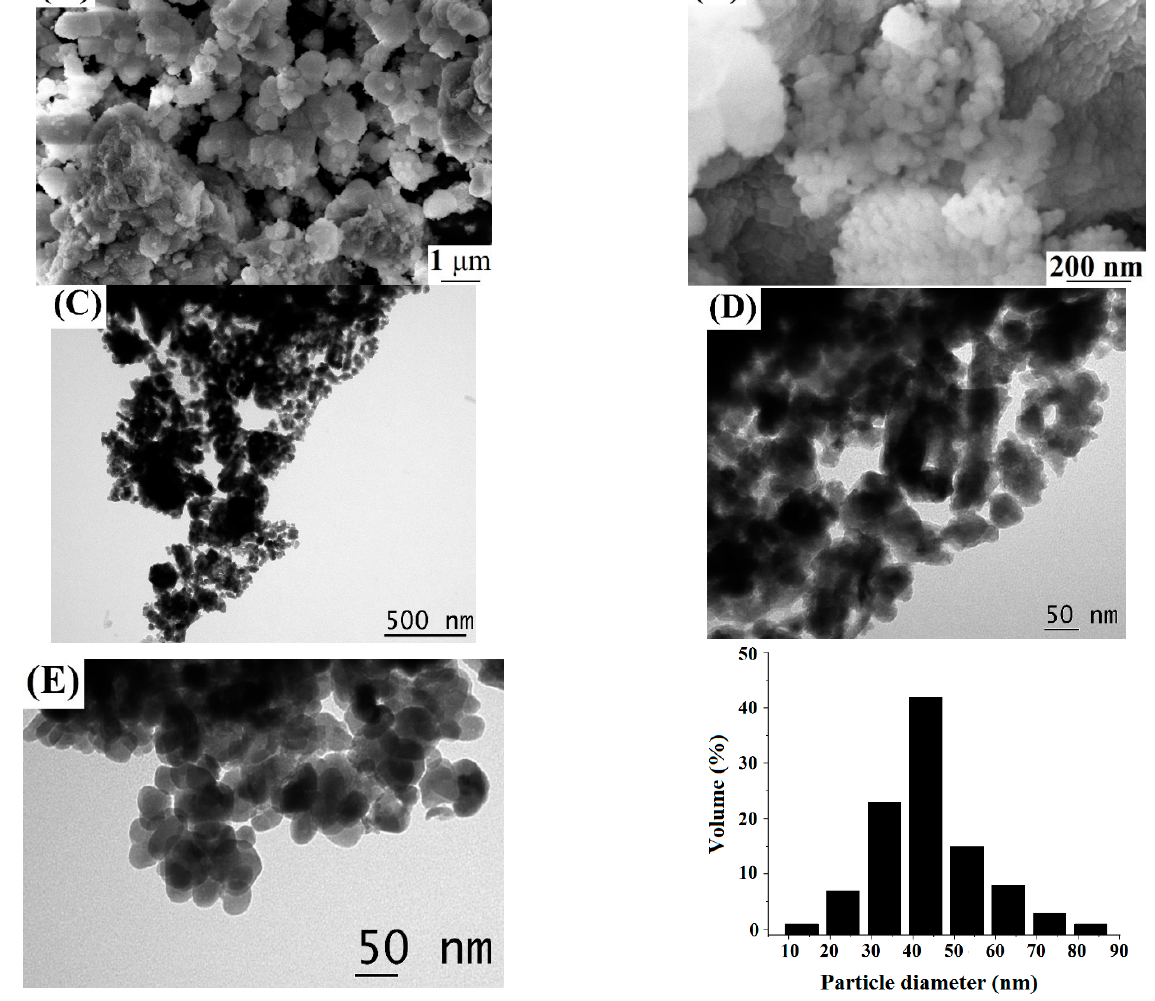
Figure 9. SEM ( A , B ) and TEM ( C – E ) images, and sample particle size distribution curve for sample 5 .